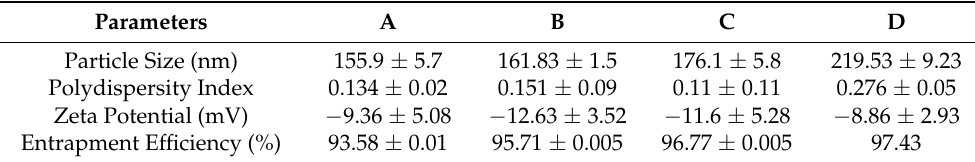
Figure 3. The result of the preparation of four catechin transethosomal formulas: ( A ) catechin concentration 0.5%; ( B ) 0.75% catechin concentration; ( C ) 1% catechin concentration; ( D ) catechin concentration 1.25%. Table 4. Characterization results of catechin transethosomes.